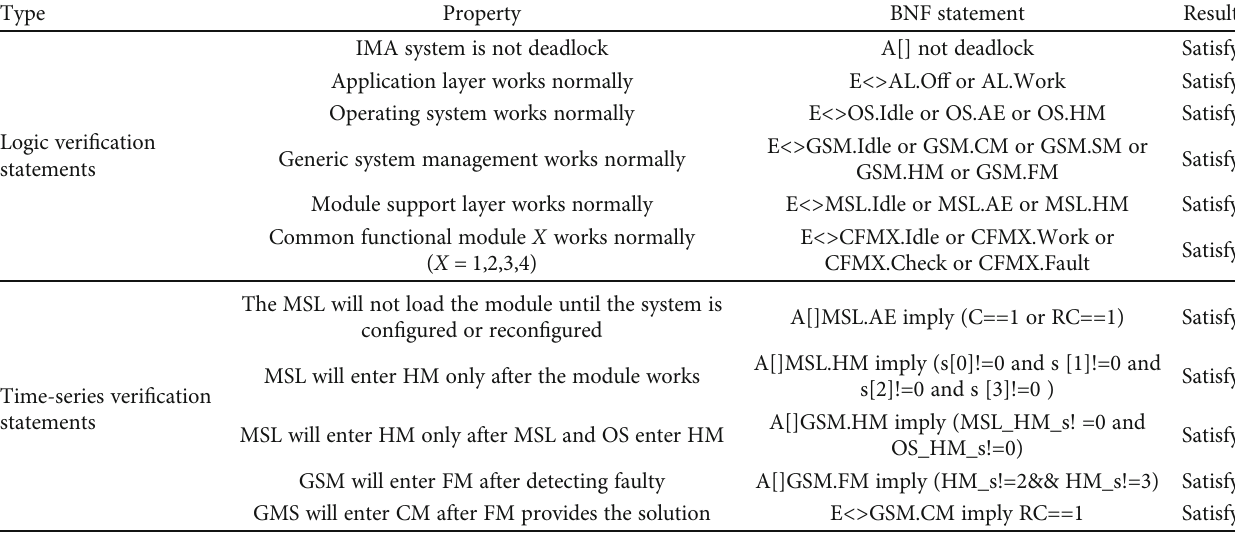
Table 3: Model veri fi cation statements.